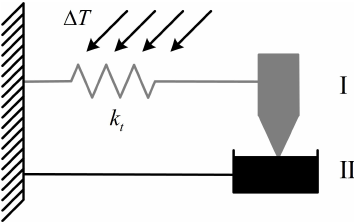
Figure 2. Static equilibrium position of frictionless clearance joints.